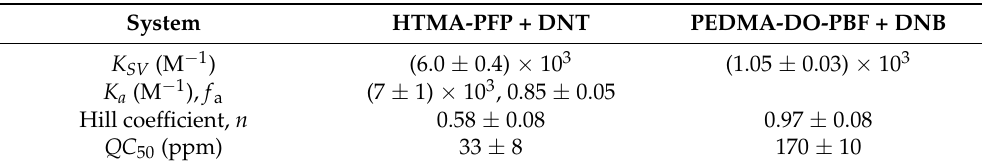
Table 1. Fitting parameters for the fluorescence quenching of cationic polyfluorenes with nitroaro-